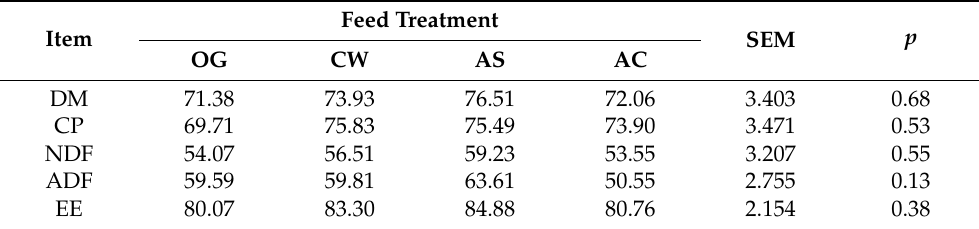
Table 4. Apparent digestibility of different forage types of TMR. %.